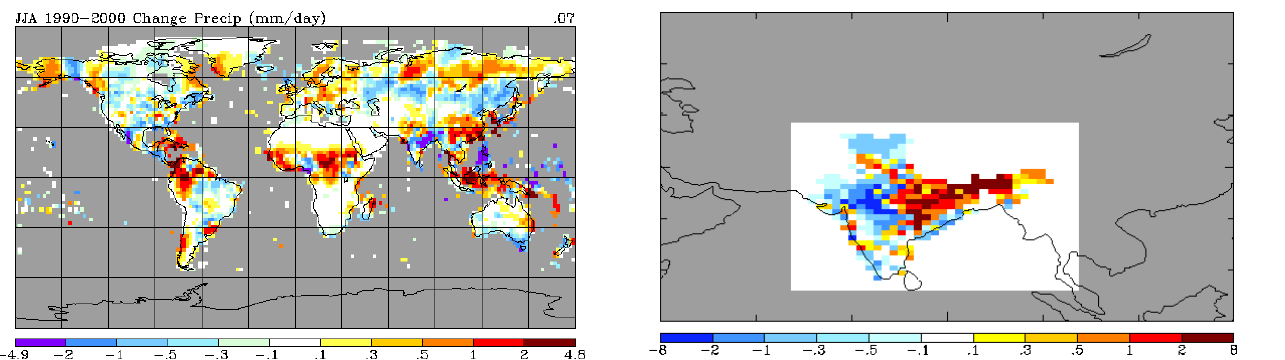
Fig. 11. Trend in summer (June to August (JJA)) precipitation from 1990 to 2000 using observations from CRU TS2.0 (Mitchell and Jones, 2005) available at http://data.giss.nasa.gov/precip cru/maps. html. Global mean change is given on the r.h.s. of the figure.